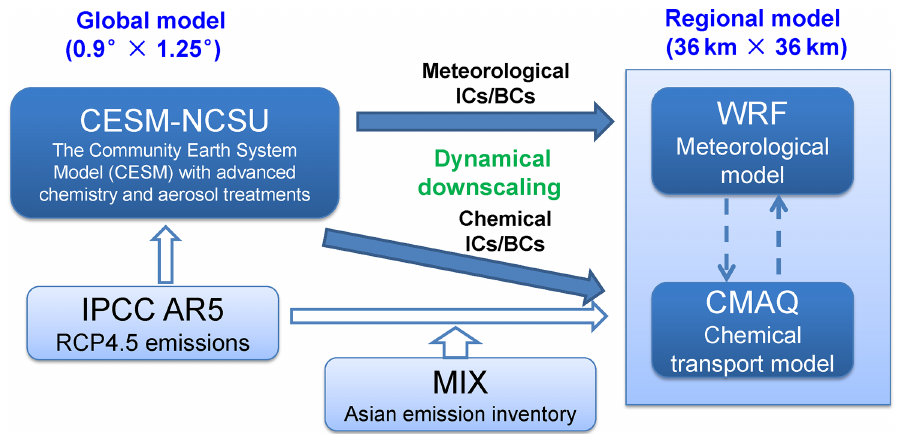
Figure 1. Modeling system in this study. The two-way coupled Weather Research and Forecasting – Community Multiscale Air Quality (WRF-CMAQ) model, which takes into account the air quality and climate interactions, is driven by the Community Earth System Model with advanced chemistry and aerosol treatments (CESM-NCSU) for high-resolution regional simulations. Both meteorological downscaling and chemical composition downscaling from the CESM-NCSU are applied to provide meteorological and chemical boundary conditions (BCs)/initial conditions (ICs) for regional WRF-CMAQ